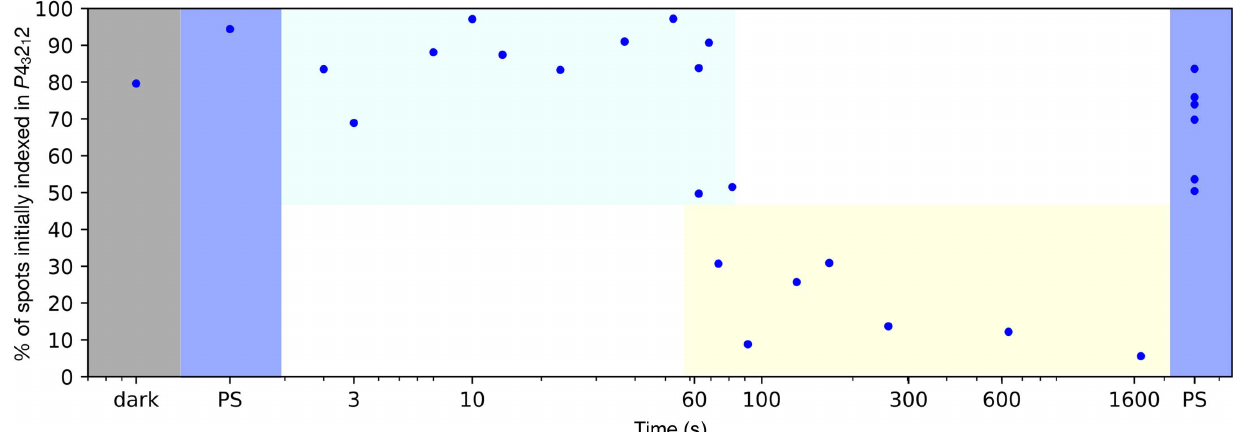
Figure 6 Initial indexing of the various datasets recorded along the illumination scheme. Each dataset was indexed by autoPROC with the space group P 4 3 2 1 2 as input. The percentage of spots indexed in the space group P 4 3 2 1 2 is represented as a function of time on a logarithmic timescale. All datasets recorded prior to, and during illumination can be confidently indexed in the space group P 4 3 2 1 2 (>50%). Datasets recorded during the first 60 to 80 s of the relaxation step also show a majority of spots initially indexed in the space group P 4 3 2 1 2. However, after 60 s, datasets begin to have less than 50% spots initially indexed in the tetragonal space group. For late time points (above 200 s), datasets exhibit an indexing percentage in the space group P 4 3 2 1 2 below 15% and can only be reliably indexed and reduced in the space group P 2 1 2 1 2 1 . The fact that all datasets recorded during a second illumination step can be indexed in the space group P 4 3 2 1 2 demonstrates the reversibility of the space group